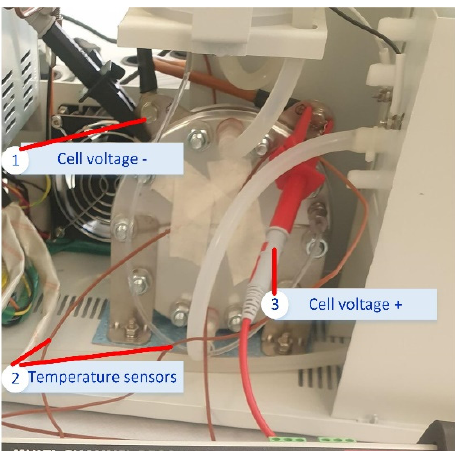
Figure 3. PEM electrolyzer cell with the measurement connections.